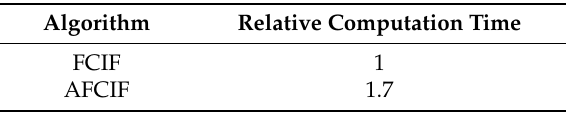
Figure 9. Comparison of RMSE (noise estimation) when the initial process noise covariance is set to be smaller than the true value. Table 1. Relative Computation Times of the algorithms.